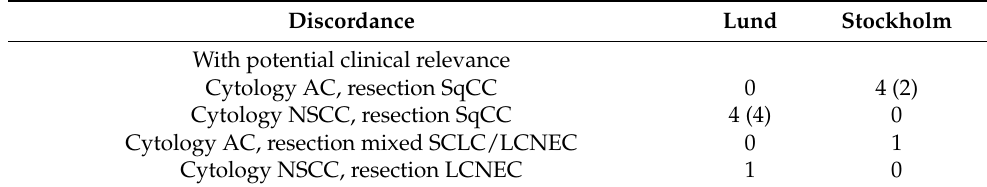
Table 2. Discordant pre-surgical diagnosis for 164 (Lund) and 174 (Stockholm) cases with resection as reference